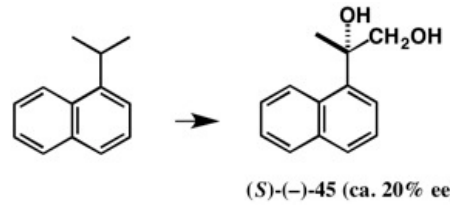
Figure 30. Biotransformation of 1- iso -propylnaphthalene to 2-(1-naphthyl)propane-1,2-diol 45 .